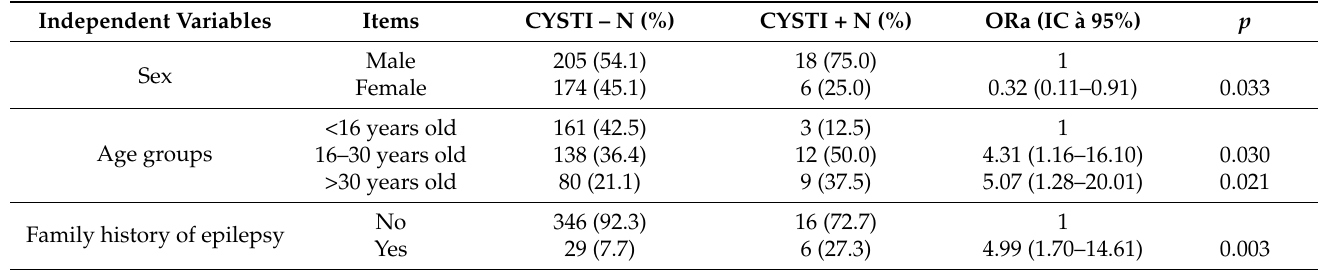
Table 4. Results of multivariate logistic regression